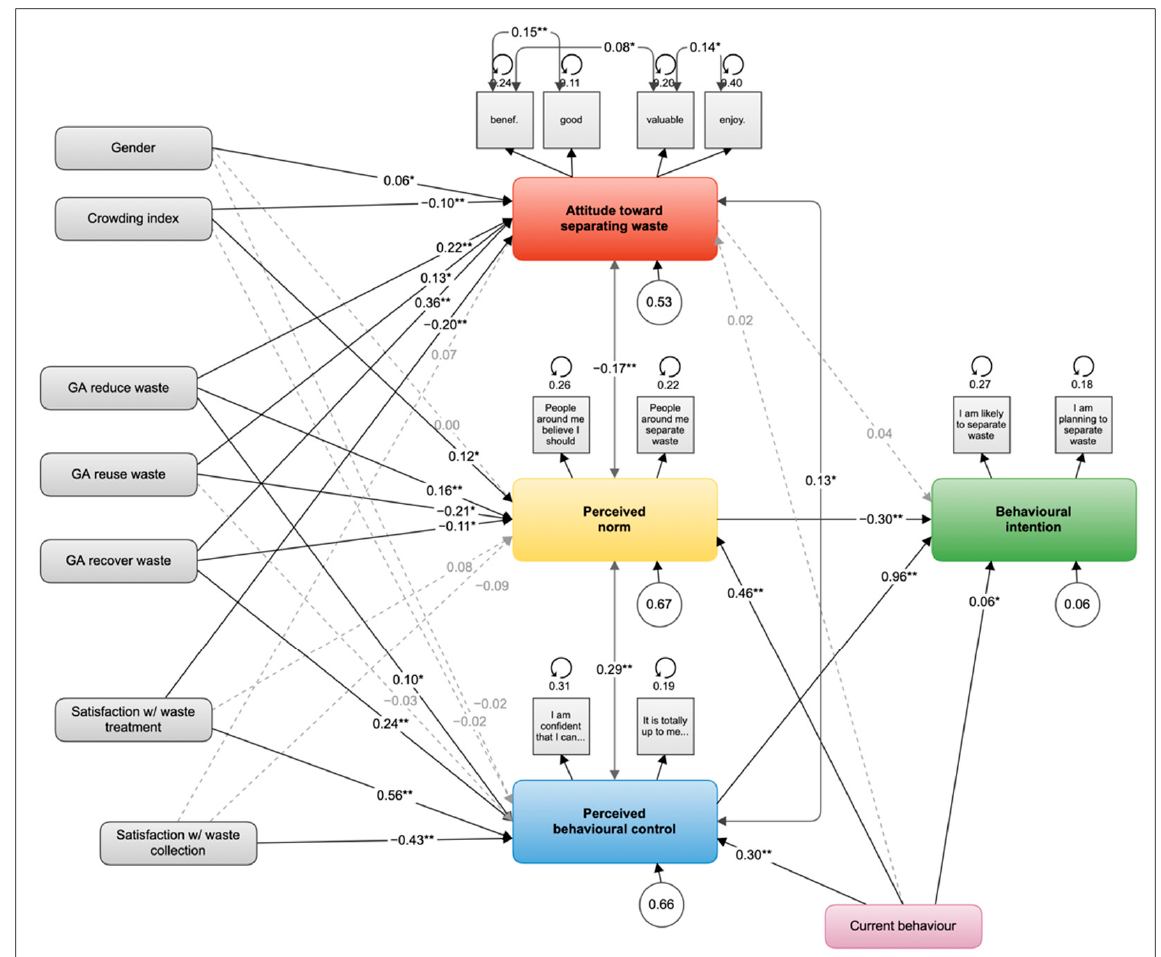
Figure 2. The tested TPB model with background factors. Notes: The latent factors representing the core TPB constructs are coloured; in grey are indicators and background factors; filled lines represent significant regression coefficients, dotted light grey arrows represent non-significant regression coefficients; numbers on paths represent the standardised path coefficients; asterisks represent the significance of the regression coefficient (* p < 0.05, ** p < 0.001); numbers in circles under each latent factor represent the unexplained variance (factor variances); and circles around indicators represent error variances (residual variances). For clarity, the path coefficients from background factors to intention are excluded except for current behaviour.